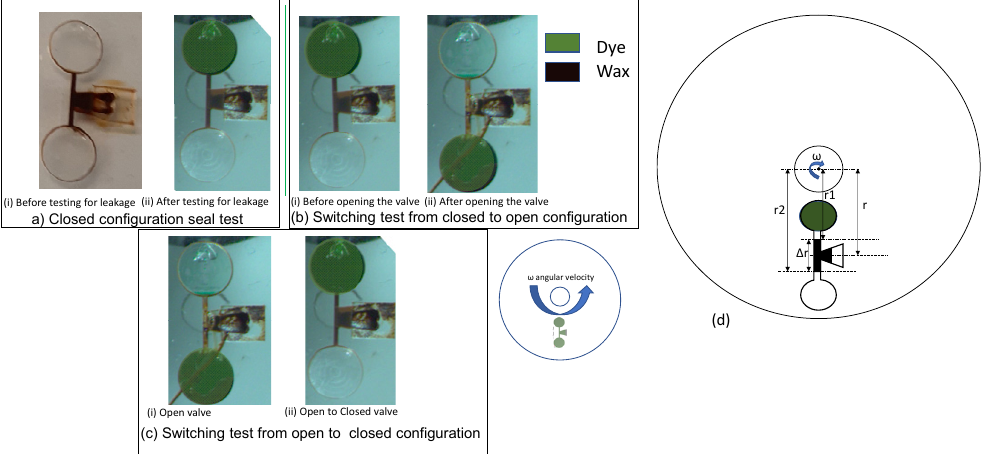
Figure 7. Experimental results after the functional testing of the capillary force ‐ based wax valve: ( a ) closed configuration seal test: test is performed on a normally closed configuration wax valve shown in ( i ) by spinning the CD at 6500 rpm in ( ii ) and checking for leakage in the lower chamber; ( b ) switching test from closed to open configuration: The wax plug in the valve channel as shown in ( i ) is melted and the disc is spun at 6500 rpm upon which the molten wax flows to the outward chamber under the influence of the centrifugal force thus enabling the fluid (green dye) to move to the out ‐ ward channel as shown in ( ii ); ( c ) switching test from open to closed configuration: The valve in the normally open configuration ( i ) is heated in the wax reservoir to melt the wax and the molten wax (again under the influence of the capillary force) flows to the channel to block the valving channel and is cooled for 15 s to solidify and seal the channel. No leakage was found ( ii ) after spinning the disc at 6500 rpm for 4 min. ( d ) Schematic of the location of the elements of the capillary wax valve on a centrifugal disc platform with respect to center of the disc. Green shaded region denotes the fluid location and black shaded region denotes the ferrowax.